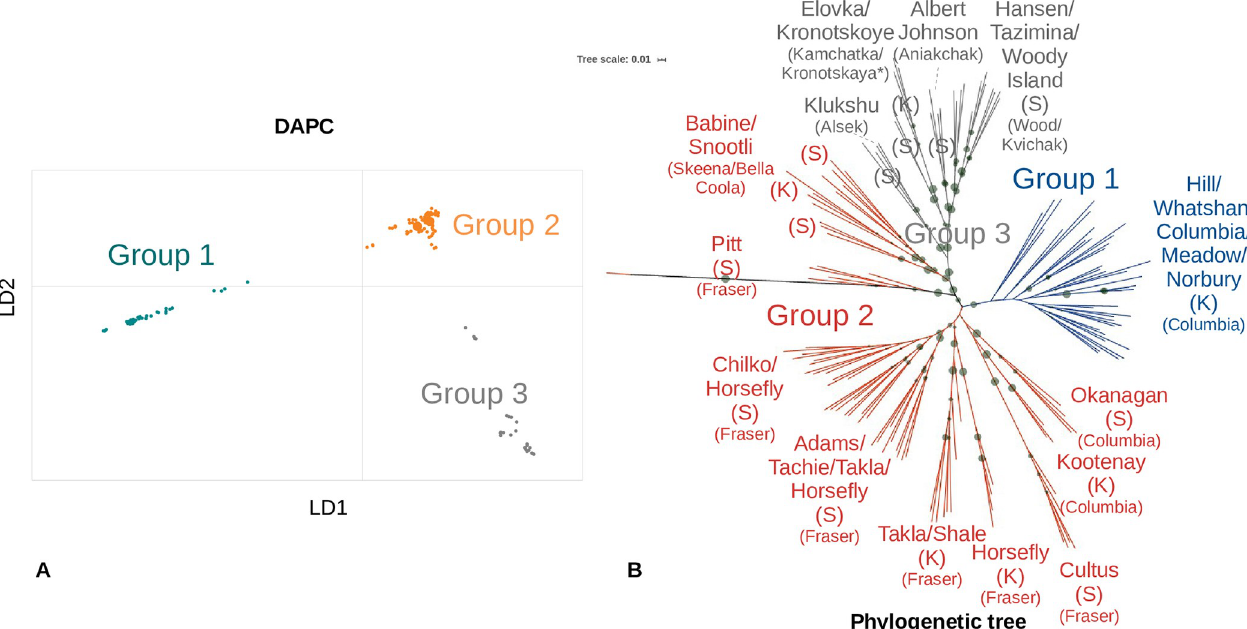
Fig 2. Clustering sockeye and kokanee individuals (population stratification). This figure shows the clustering of individuals based on: A) DAPC and B) maximum likelihood analysis (phylogenetic tree). Both analyses began with the same 124,663 variants already filtered for common factors (e.g. maf 0.05) and was specifically filtered for linkage disequilibrium (LD), to reduce the effects of a single genomic location in high LD overwhelming all other signals. A) DAPC analysis clustering with the optimal group number [3] and optimal number of PCAs chosen [6]. The axes represent the first two linear discriminants (LD1 and LD2). The gray, coral (red/orange), and teal (blue) colours correspond to the different clusters. B) An unrooted maximum-likelihood phylogenetic tree, with bootstrap values (based on 1,000 bootstraps) shown as green dots with the larger dots representing greater bootstrap values (min: 0.1 max: 100). Only 7,357 variants remained after default SNPhylo filters. Colours are consistent with the DAPC analysis (DAPC group names shown for comparison). Please note in the Klukshu and Hansen groups, one individual from the other group was found in the grouping and likely represents a switched sample (see S1 Table). Also, there is one Takla kokanee in the Hansen grouping. Sockeye are represented by (S) and kokanee are represented by